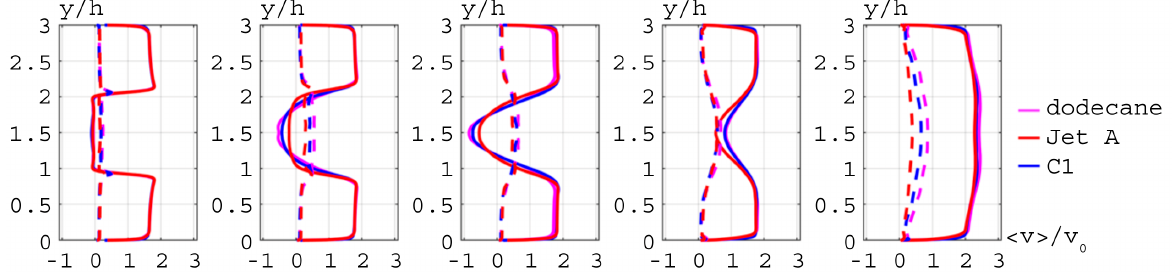
Figure 6. Comparison of time-averaged axial velocity, (cid:104) (cid:101) v x (cid:105) , and axial rms velocity fluctuations, v rms x , at x / h = 0.375, 0.95, 1.53, 3.75, and 9.40, from left to right, between the LES-LDKM-EDC simulations of n-dodecane, Jet A, and C1 at φ = 0.66 .